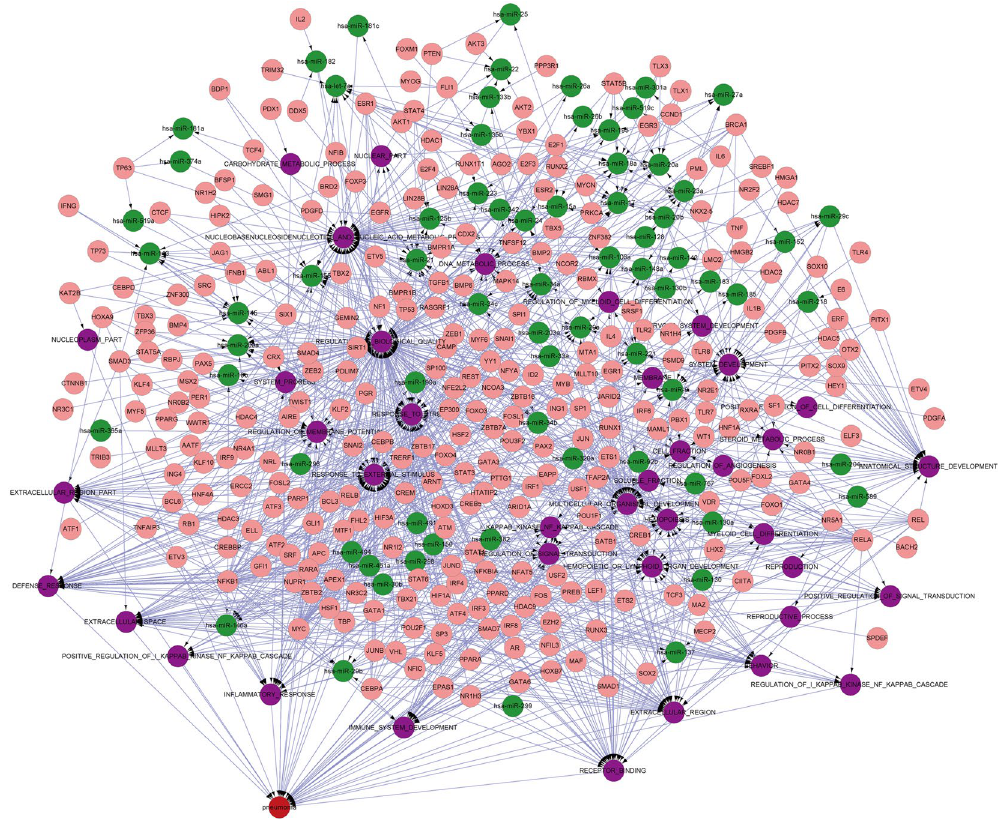
Figure 6. The complex regulatory module of Pneumonia. The red nodes represent side effects; the purple nodes represent gene sets; the green nodes represent miRNAs and the pink nodes represent TFs. Pneumonia, with 39 sets of genes regulated by miRNAs and